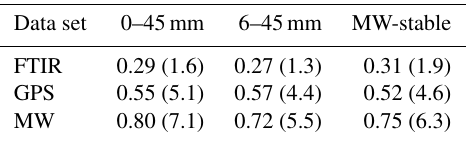
Table 6. Empirical statistical errors of FTIR, GPS, and MW meth- ods, as obtained from Eq. (2) for different data sets. Estimates are given in mm and in percent in